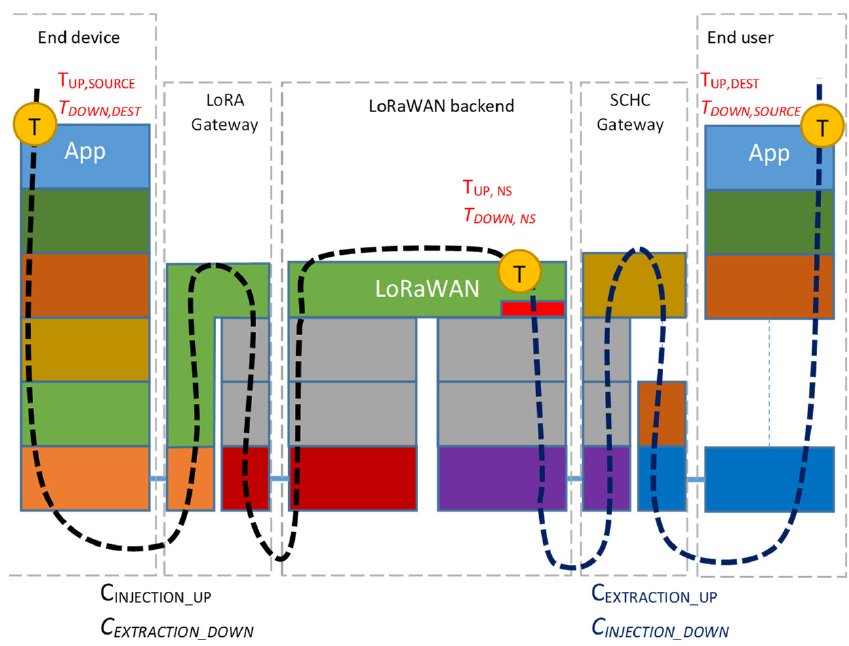
Figure 7. Proposed methodology: identification of data flows for uplink and downlink directions (italics ); identification of timestamping points (yellow dots); and identification of timestamps for uplink and downlink ( italics ).